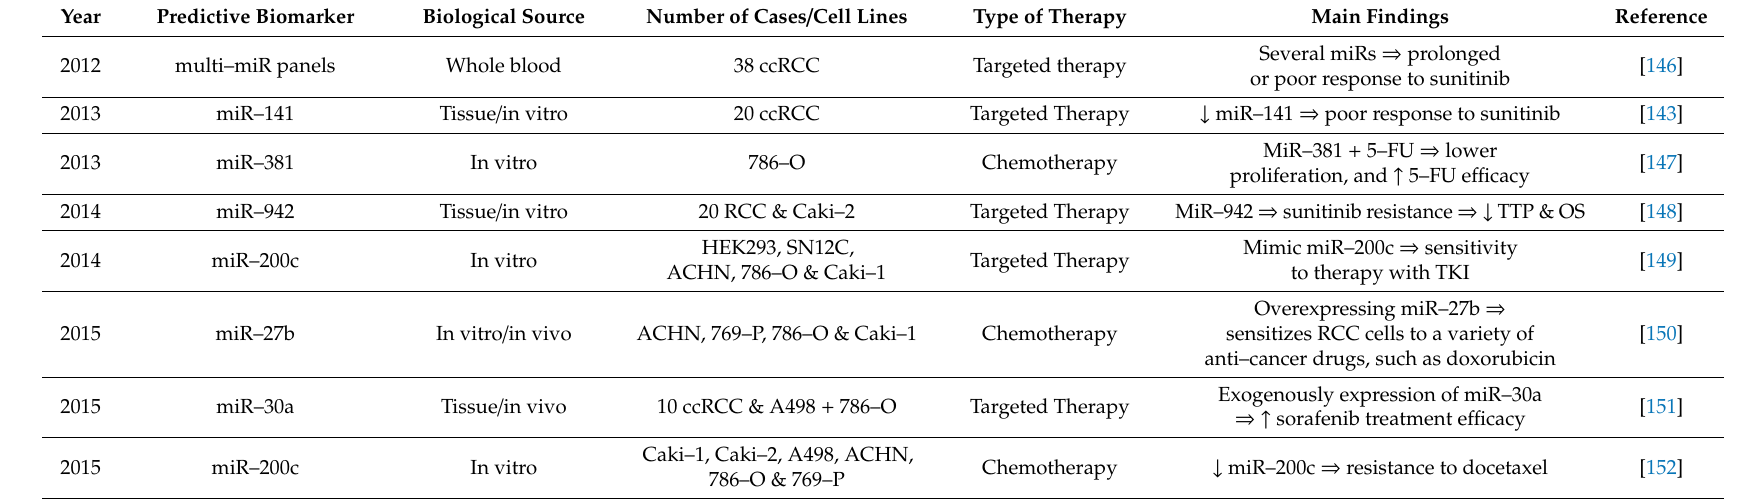
Table 5. Therapy predictive sncRNAs for RCC in tissue, liquid biopsies, and in vitro